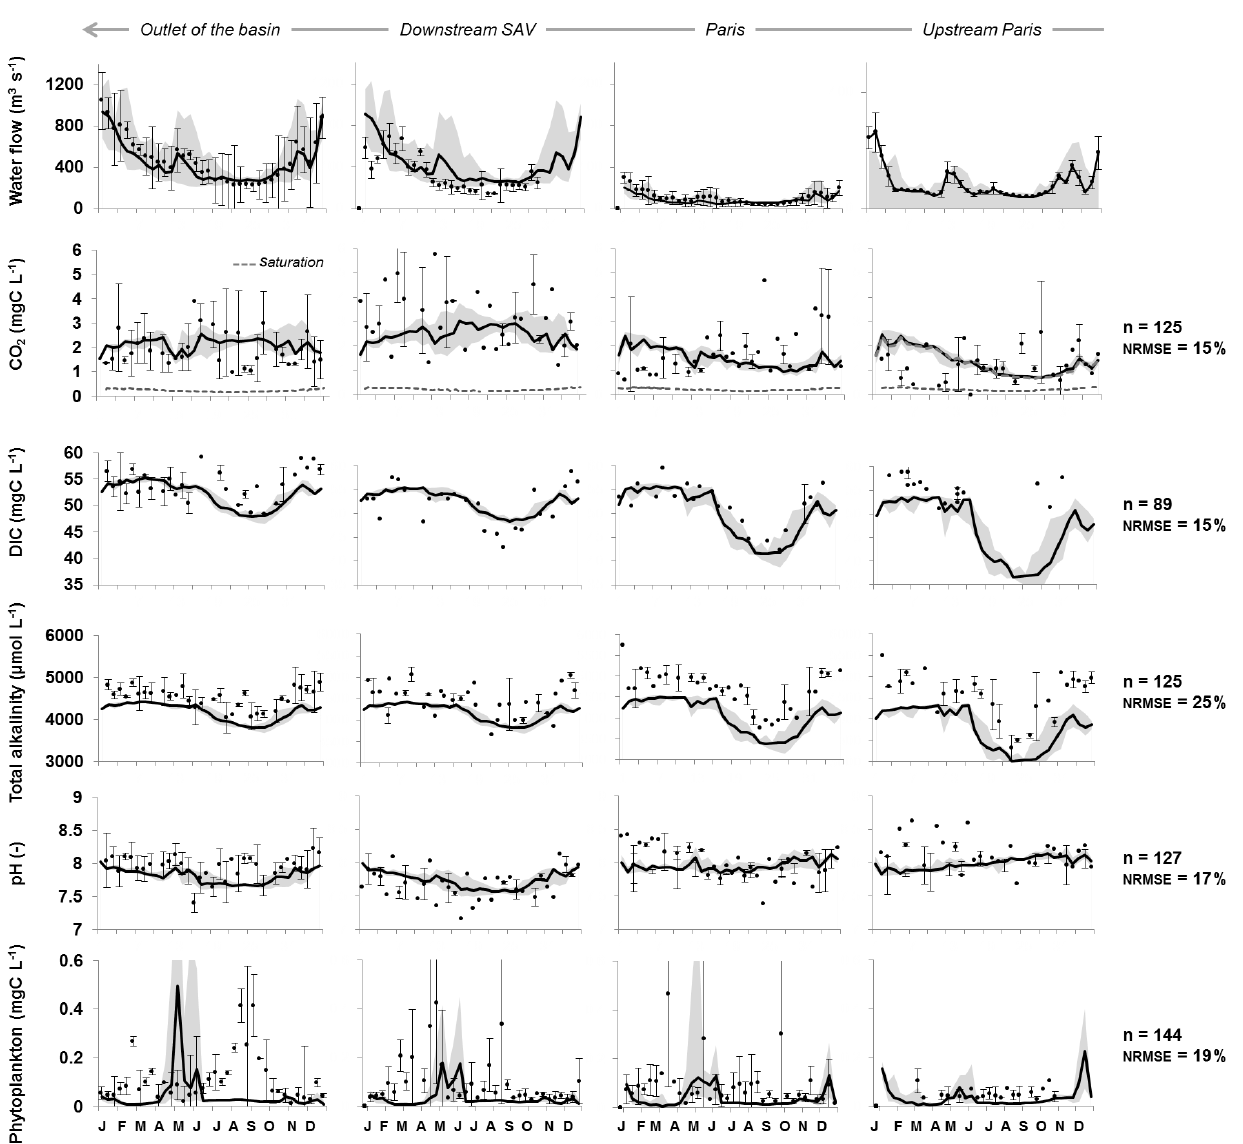
Figure 6. The 10-day simulated (lines) and observed (dots) water discharges over the 2010–2013 period ( Q , m 3 s − 1 ), concentrations of carbon dioxide (CO 2 , mgCL − 1 , and CO 2 sat, mgCL − 1 ), dissolved inorganic carbon (DIC, mgCL − 1 ), total alkalinity (TA, µmolL − 1 ), pH (–), and phytoplankton (mgCL − 1 ). Four monitoring stations of interest along the main stem of Marne–lower Seine are shown: Ferté- sous-Jouarre (upstream of Paris on the Marne River), Paris on the lower Seine (upstream at Charenton), downstream of the SAV WWTP and at the outlet of the basin (Poses). NRMSE analyses were performed on inter-annual variations per decade for the 2010–2013 period, combining observations and simulations at four main monitoring stations. The simulation envelope corresponds to standard deviations (gray area). For observed data, whiskers are standard